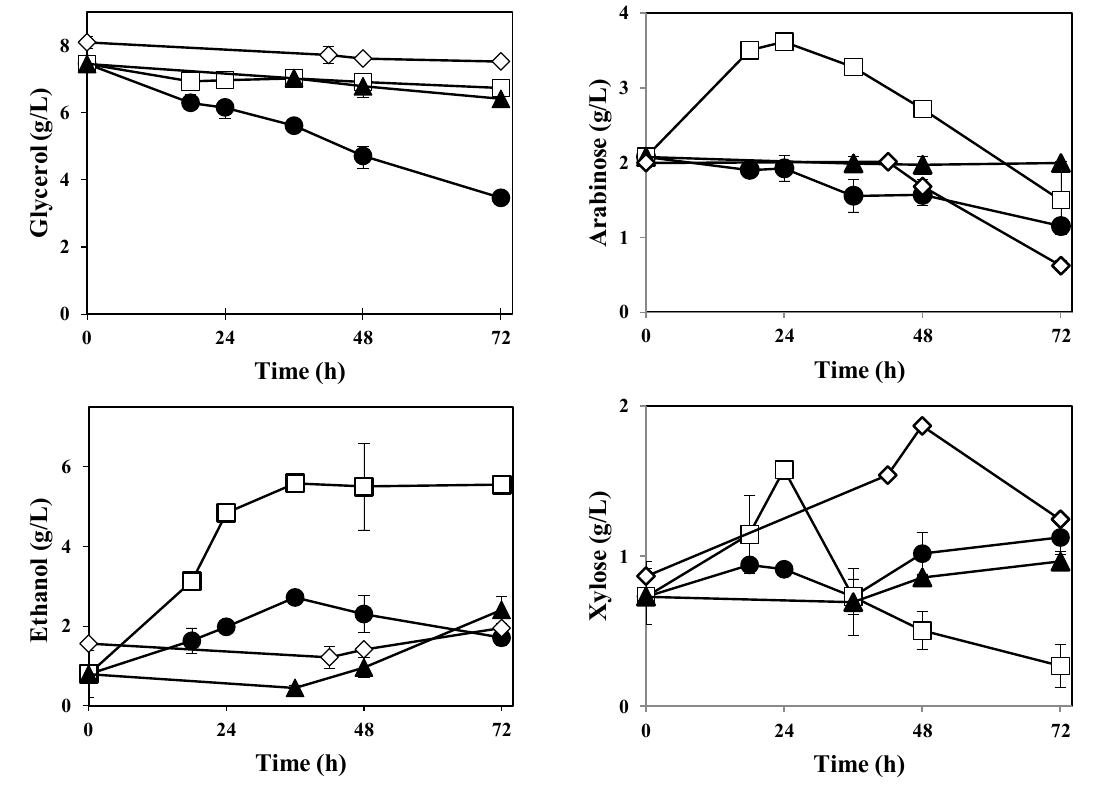
Figure 5. Concentration profiles of glycerol, ethanol, arabinose and xylose during cultivation of Ascomycetes in thin stillage at 30 °C. A. oryzae (circles), N. intermedia (squares), F. venenatum (triangles), M. purpureus